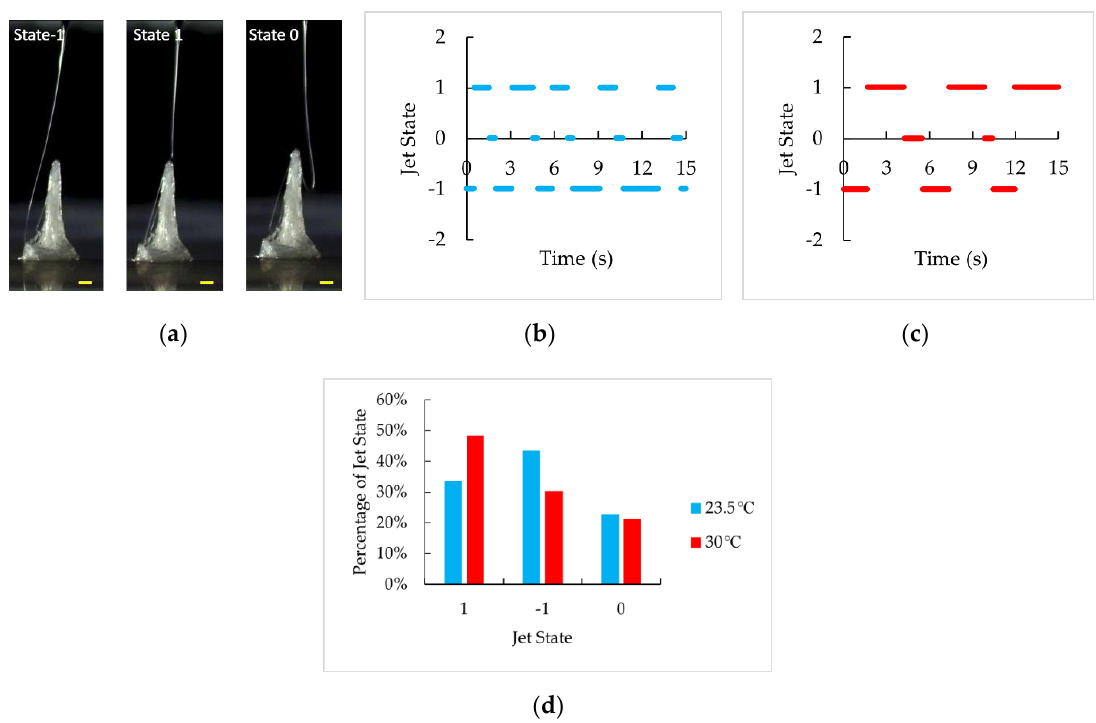
Figure 6. Effect of collector temperature on the dynamic jet deposition process (printing time 5–5.25 min): ( a ) jet states −1, 1, and 0 at 30 °C; The scale bars denote 1 mm. ( b ) evolution of jet state at 23.5 °C; ( c ) evolution of jet state at 30 °C; ( d ) percentage of different jet states at 23.5 °C and 30 °C. State 1, −1 and 0 represents the jet deposition point is on the central cone, outer cone or transitioning from the central cone to the outer ring on the fiber deposits.